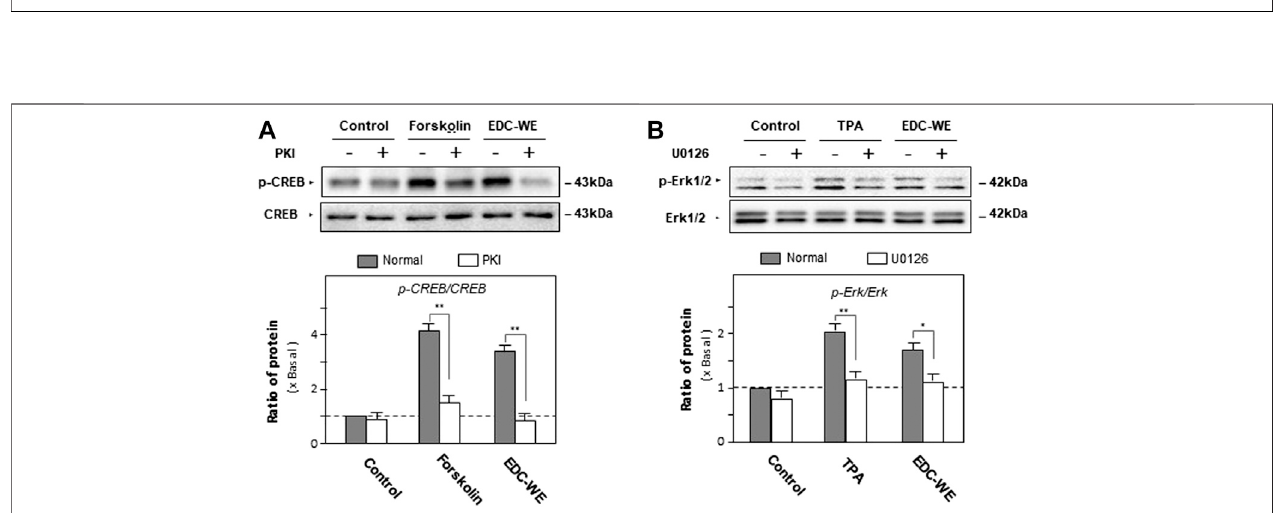
FIGURE5| TheeffectoftheaqueousextractofElaphuriDavidianiCornu(EDC)onthephosphorylationofkinasesofthecAMP-andErk-dependentpathwaysinthe mouse astrocyte primary cultures. (A) : Mouse astrocyte primary cultures were pre-treated with PKI (10 nM) for 3 h and then treated with forskolin (10 μ M) and the aqueous extracts (EDC-WE) (3 μ g/ml) for 24 h. Protein-expression levels of p-CREB and CREB in astrocyte primary cultures were determined by western blot analysis. Data are expressed as a fold-change relative to the control group (no-drug treatment) in the ratio of p-CREB to CRRB as mean ± SEM, where n (cid:1) 5. (B) : Mouse astrocyte primary cultures were pre-treated with U0126 (2 μ M) for 3 h and then treated with TPA (100 nM) and the EDC aqueous extract (EDC-WE) (3 μ g/ml) for 24 h. Protein-expression levels of p-Erk and Erk in astrocyte primary cultures were determined by western blot analysis. Data are expressed as a fold-change relative to the control group (no-drug treatment) in the ratio of p-Erk to Erk as mean ± SEM, where n (cid:1) 5. * p < 0.05, ** p < 0.01.